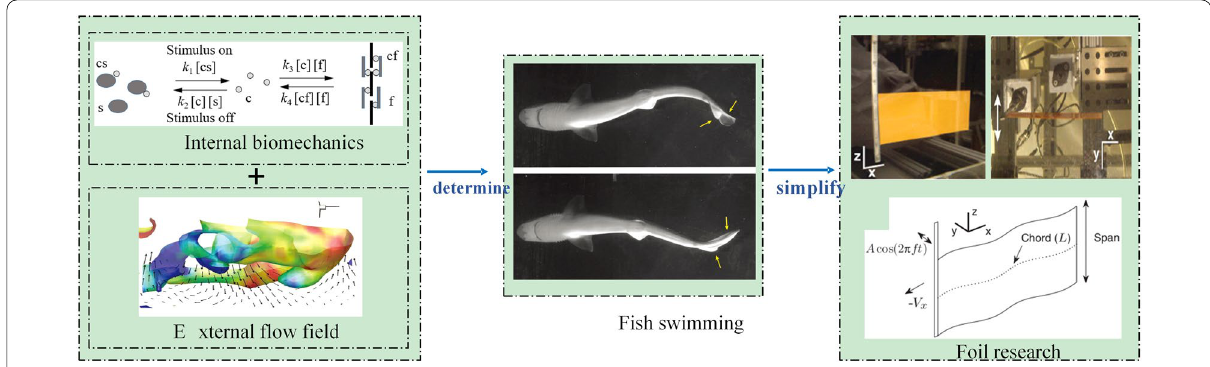
Figure 1 Experimental research of fish swimming (The figures of external flow field and fish swimming are reproduced from Ref. [13]. The figures of internal biomechanics and foil research are reproduced from Refs. [14] and [15],